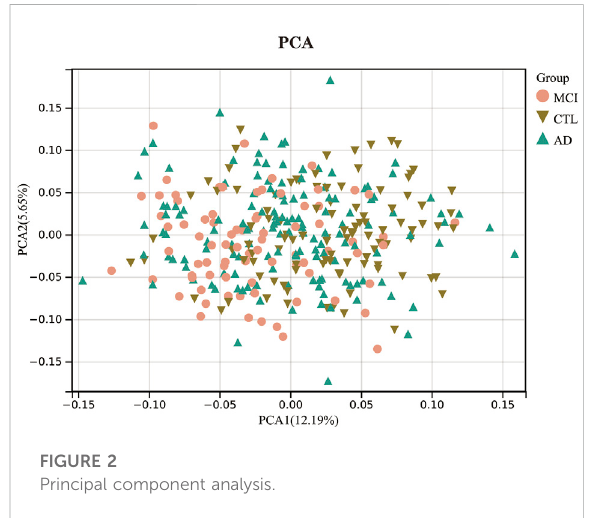
FIGURE 2 Principal component analysis.